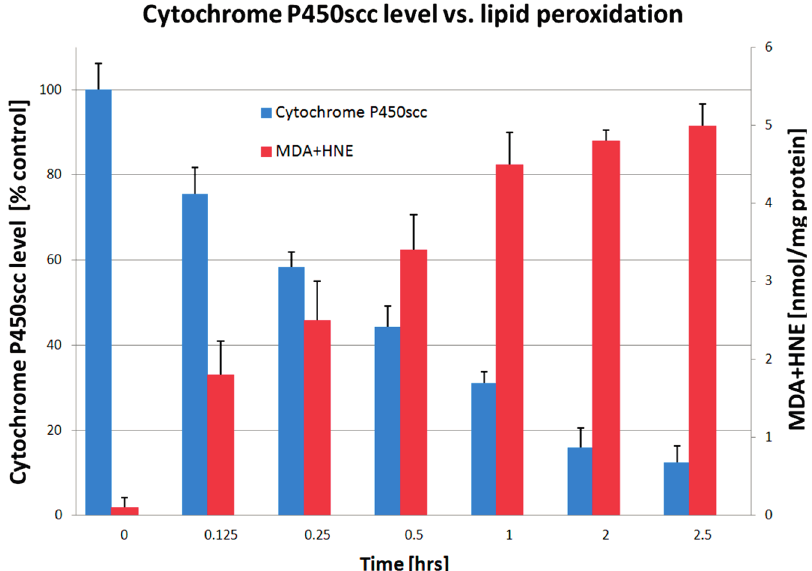
Figure 4. Cytochrome P450scc level after treatment with arachidonic acid hydroperoxide (AA(OOH)). Lipid peroxidation induced by AA(OOH) was measured from the production of MDA and HNE. Data are presented as mean ± SD obtained from five independent experiments expressed as percentage of control.